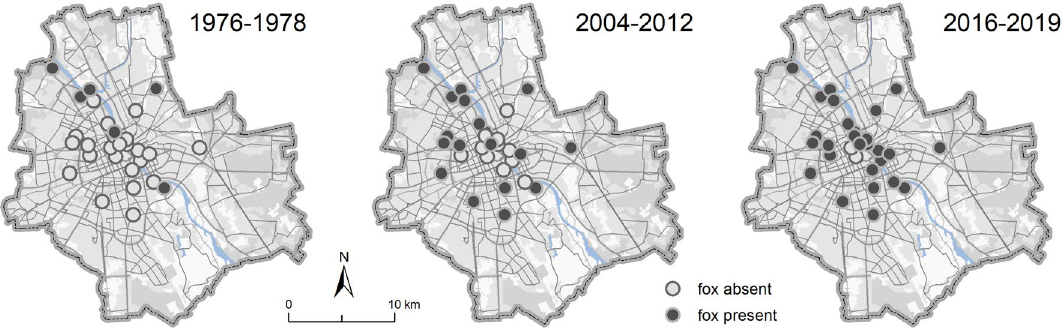
Figure 3. Presence of the red fox as confirmed by snow tracking in 29 randomly selected green areas in Warsaw in the three study periods (data for 1976–1978 after Goszczyński J.,